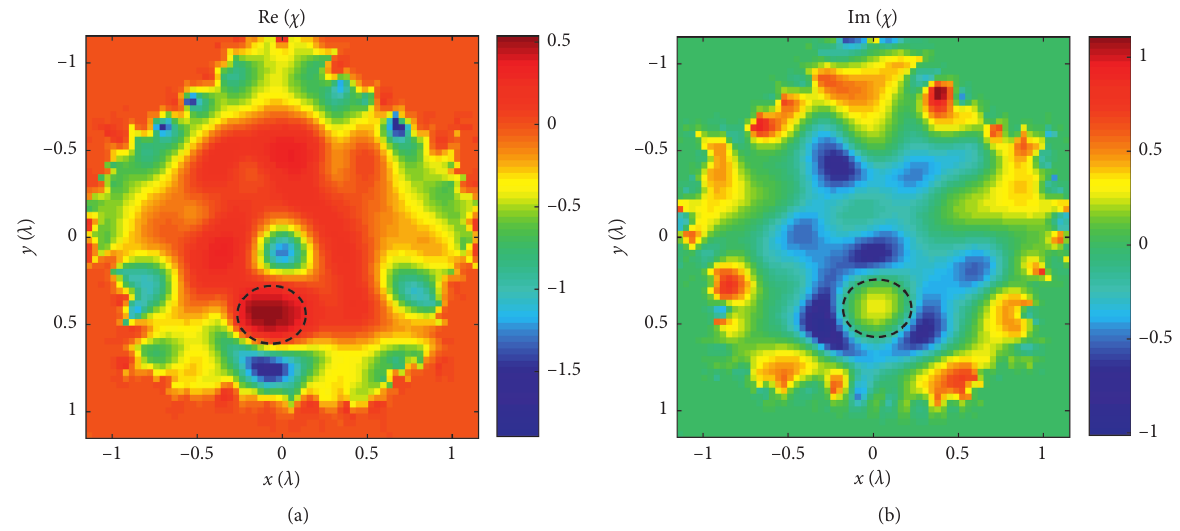
Figure 7: Real (a) and imaginary (b) part of the contrast function χ for the second